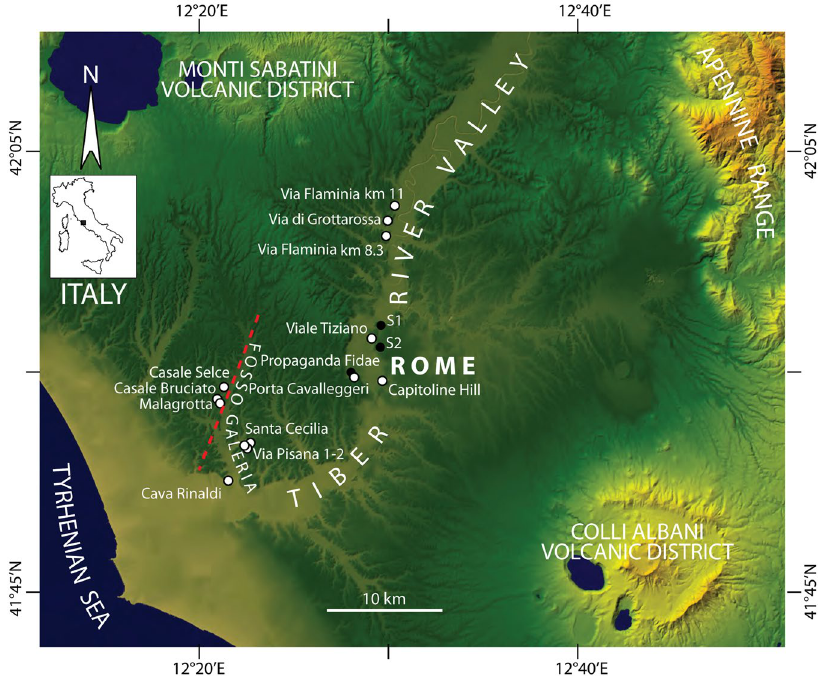
Figure 1. Digital Elevation Model (DEM) showing the investigated area of the Tiber River Valley and the Tyrrhenian Sea coast. Modified after TINITALY/01 square WA 6570, used with permission of the Istituto Nazionale di Geofisica e Vulcanologia, Rome. Locations of the investigated sections and interpreted boreholes are shown (open and filled circles,